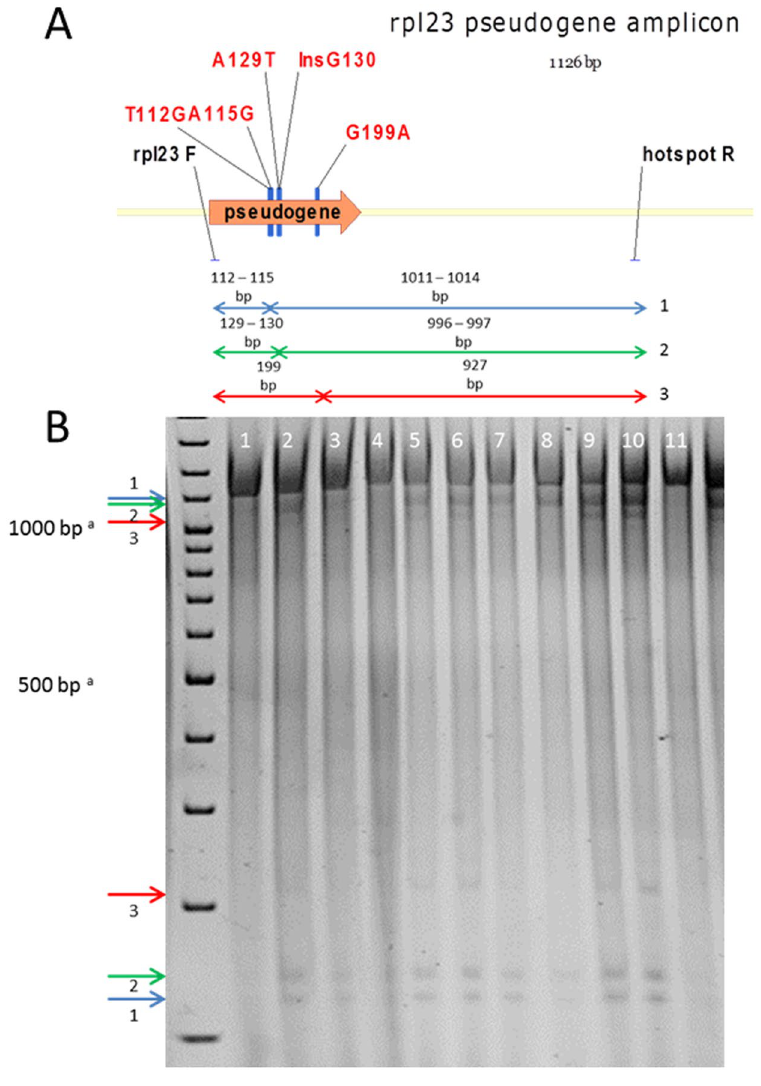
Figure 4. The rpl23 pseudogene amplicon. ( A ) Polymorphisms detected in the rpl23 pseudogene. ( B ) CJE digestions of rpl23 pseudogene amplicons on a nondenaturing 3% polyacrylamide gel. The cpm samples show different digestion patterns because they carry several combinations of polymorphisms: seedlings 1, 4 and 11 do not carry any polymorphism; seedlings 2, 3 and 8 carry T112G, A115G, A129T and InsG130; seedlings 5, 6, 7, 9 and 10 carry T112G, A115G, A129T, InsG130 and G199A. a The samples run slower than the molecular weight marker probably due to the components of the CJE digestion